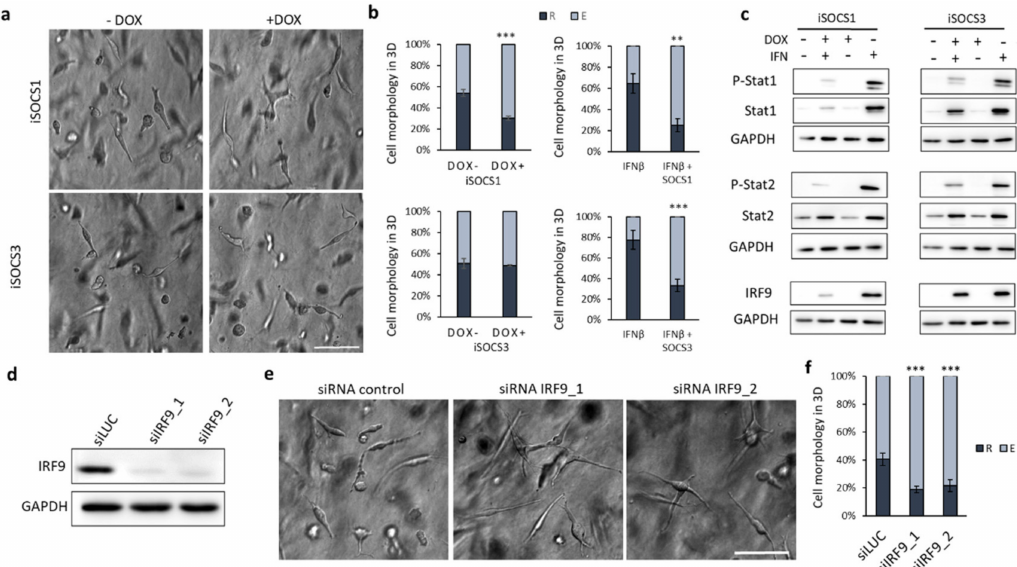
Figure 4. Downregulation of IFN signalling by IRF9 knockdown or SOCS1 expression promotes the mesenchymal phenotype. ( a ) Representative image of WM3629 after 48 h in 3D collagen expressing inducible SOCS1 and SOCS3 (iSOCS1 and iSOCS3). ( b ) Quantification of morphology of WM3629 cells with induced expression of iSOCS1 and iSOCS3 alone (left) and pre-treated with IFN β (right) cultured in 3D collagen for 48 h (overall exposure to IFN β 96 h). ( c ) Immunoblotting for proteins in samples of WM3629 cells with iSOCS1 and iSOCS3 expression treated with doxycycline (DOX) and / or IFN β (48 h). ( d ) Downregulation of IRF9 after siRNA KD verified by immunoblotting. ( e ) Representative image of WM3629 cells in 3D collagen treated with siRNA. ( f ) Quantification of morphology of WM3629 cells with siRNA KD of IRF9 in 3D collagen. Scale bar 100 µ m. R = round, E = elongated. p -values: *** p < 0.001, ** p < 0.01. Detailed information about Western blot can be found at Figure